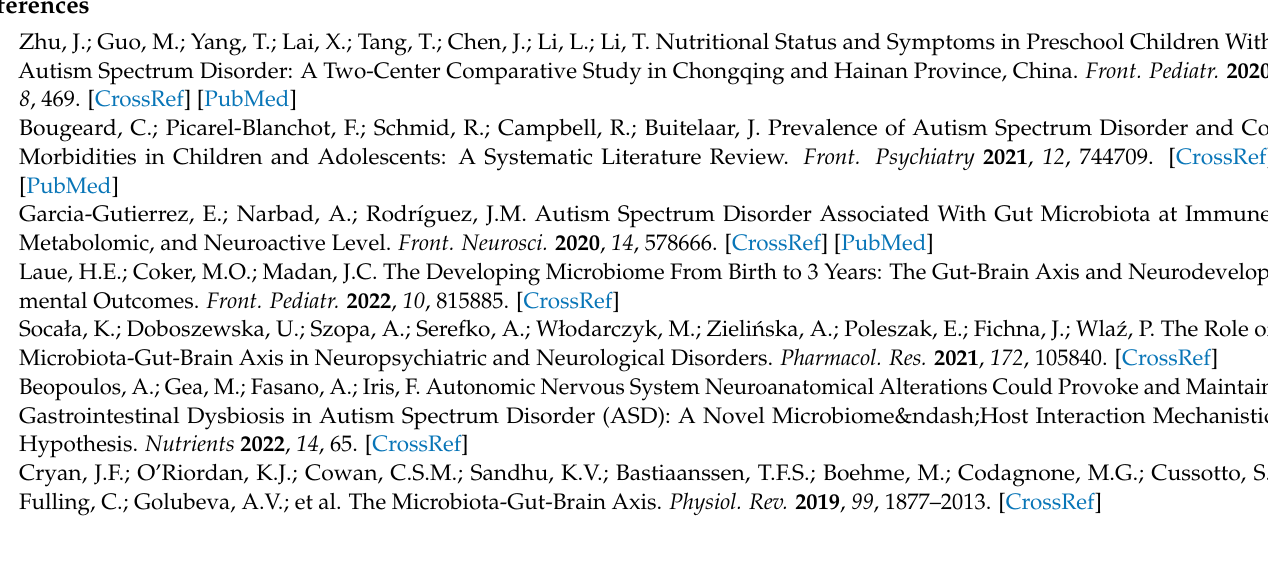
Table S4: Prebiotic Indexes (PIs) per subject for each one of the treatments included in this study, Table S5: Total short-chain fatty acids (TSCFAs) and SCFAs concentrations ( µ mol mL − 1 of sample), at the beginning of the fermentation for the ASD and neurotypical group, Table S6: Differences ( ∆ ) in SCFAs concentrations ( µ mol mL − 1 ) after 8h ( ∆ C t8-0 ) and 24h of fermentation ( ∆ C t24-0 ) for the ASD children group, Table S7: Differences ( ∆ ) in SCFAs concentrations ( µ mol mL − 1 ) after 8h ( ∆ C t8-0 ) and 24h of fermentation ( ∆ C t24-0 ) for the neurotypical children group, Table S8: % Differences ( ∆ ) in children group and Table S9: % Differences ( ∆ ) in SCFAs concentrations ( µ mol mL − 1 ) after 8h ( ∆ C t8-0 ) and 24h of fermentation ( ∆ C t24-0 ) for the neurotypical children